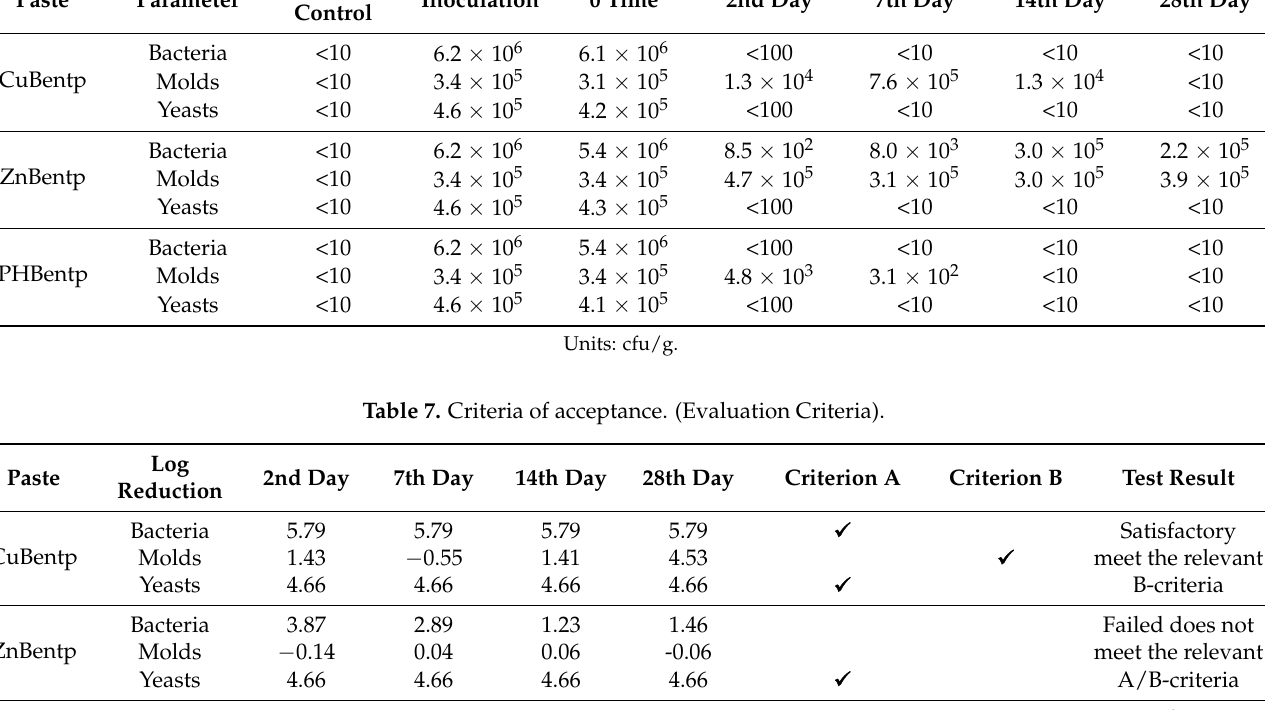
Table 6. Mixed culture—Preservation efficacy test.